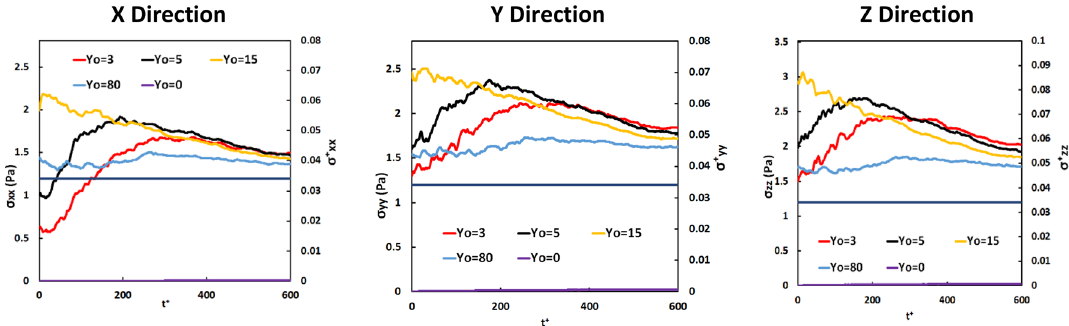
Figure 2. Mean of the absolute value of extensional stress for particles released at different positions in the Poiseuille–Couette flow field over time. The dark blue line represents the critical stress of 1.2 Pa for the case modeled